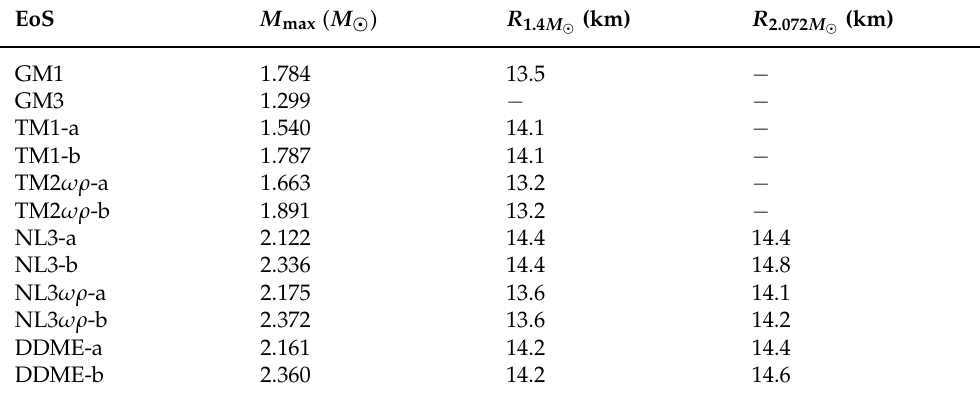
Table 3. Maximum masses, radius at M = 1.4 M (cid:12) , and radius at M = 2.072 M (cid:12) for 12 EoSs without magnetic